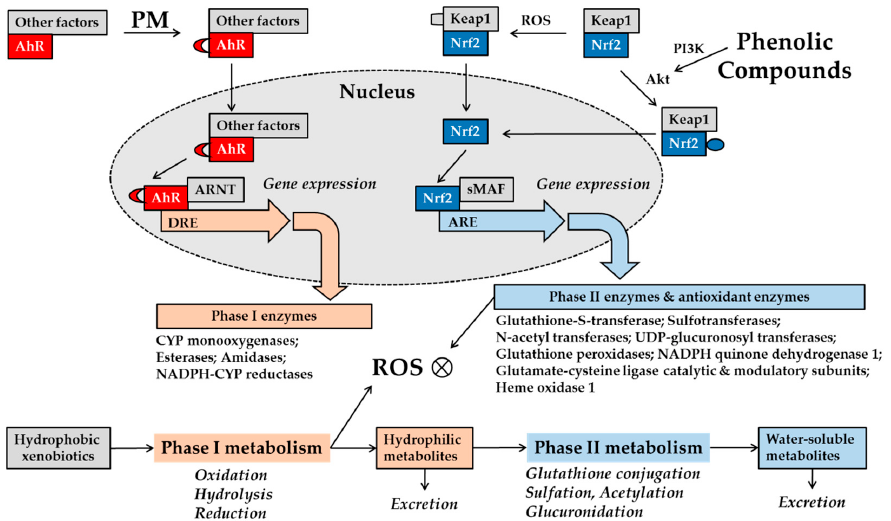
Figure 1. Schematic of aryl hydrocarbon receptor (AhR) and nuclear factor erythroid 2-related factor (Nrf2) in metabolism phases I and II of xenobiotics. Xenobiotics, including drugs and pollutants from 2 (Nrf2) in metabolism phases I and II of xenobiotics. Xenobiotics , including drugs and pollutants external sources, normally undergo phase I metabolism followed by phase II metabolism inside cells